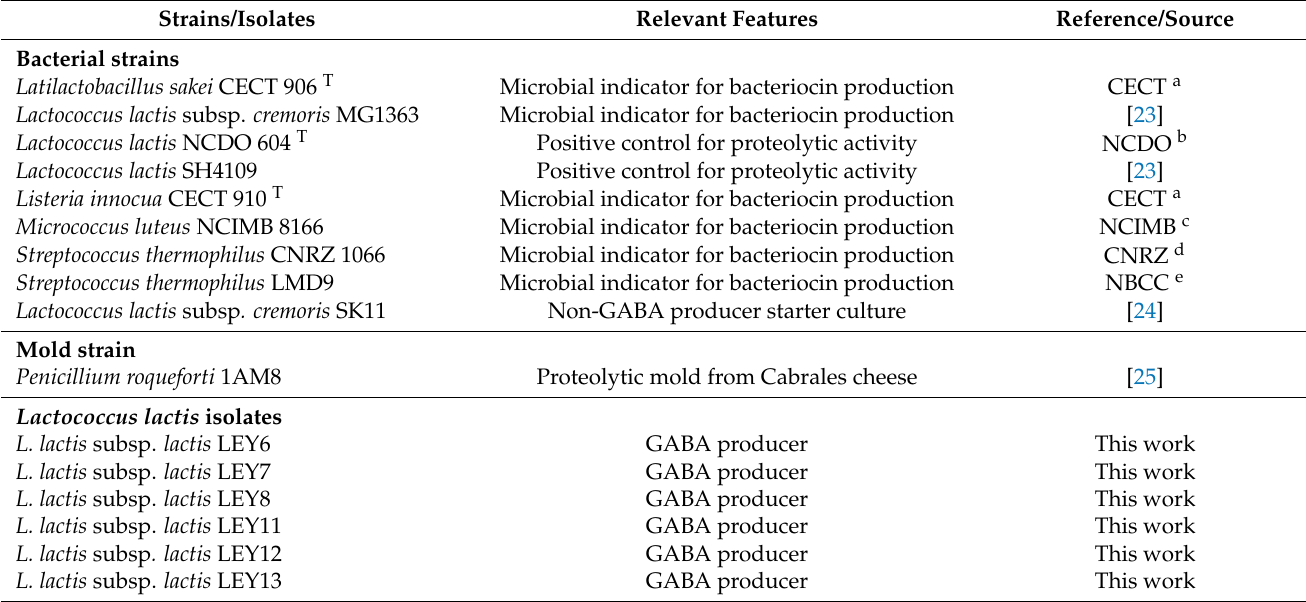
Table 1. Microorganisms used in this